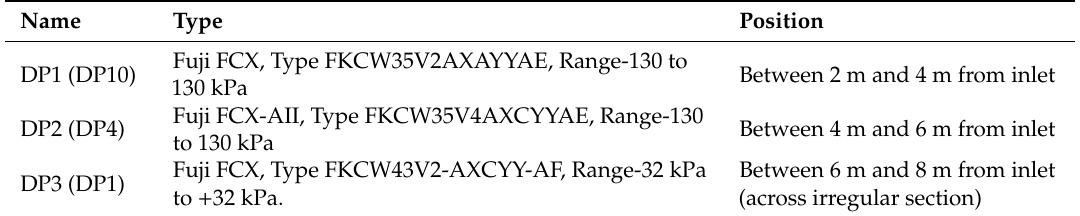
Table 3. Di ff erential pressure